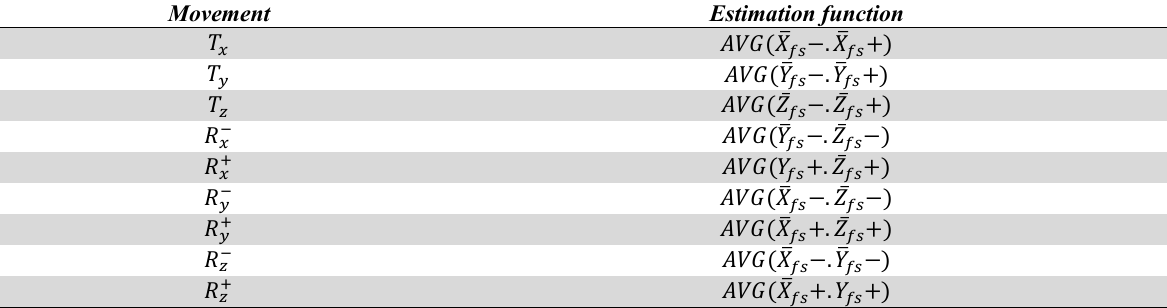
Assignation of the six values of free space ( 𝑓𝑠 ) to the nine movements. Movement Estimation